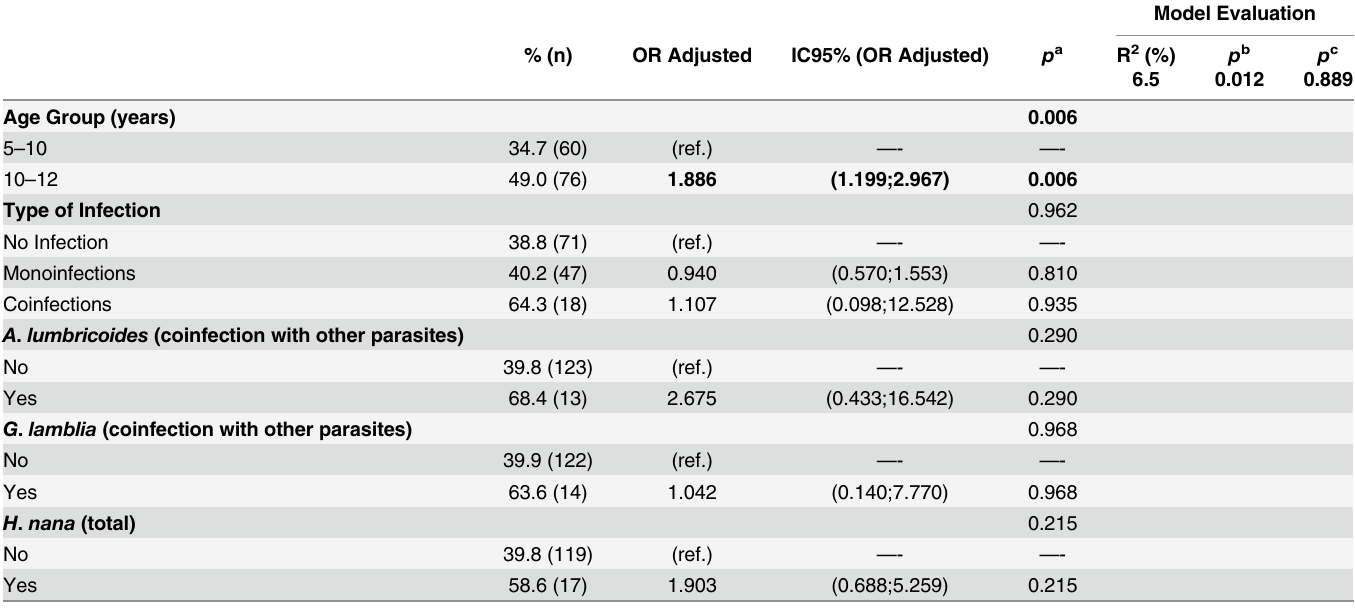
Table 6. Multivariate regression model for stunting.